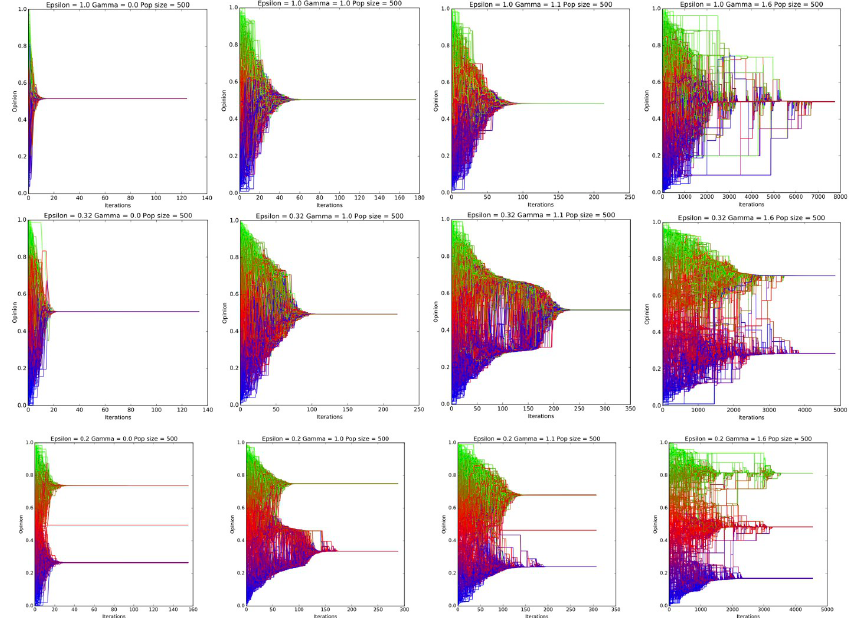
Fig 5. Evolution of the population of opinions for various γ and ε values. The first row corresponds to the case where ε = 1, the second row corresponds to ε = 0.32 while the last row corresponds to ε = 0.2. In all cases γ 2 {0, 1, 1.1, 1.6} (left to